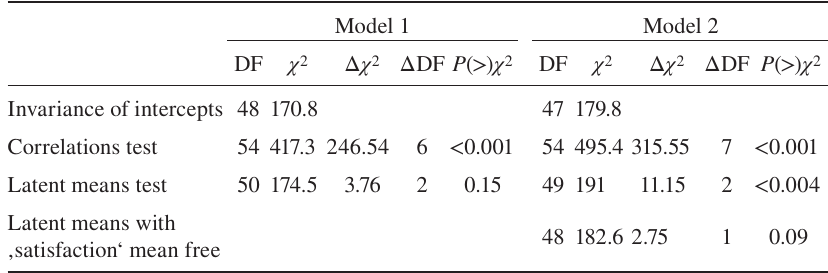
Likelihood ratio test - Within subject differences in latent means and